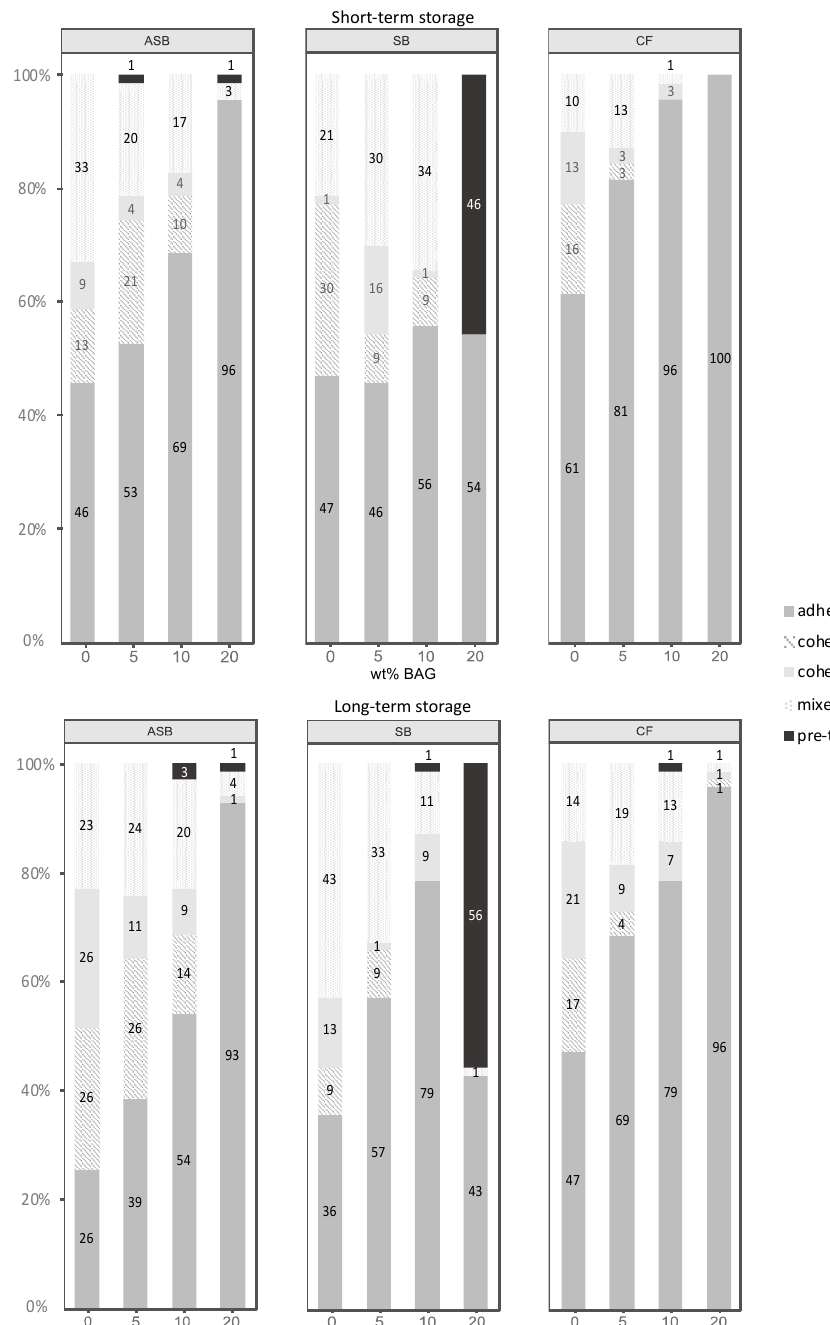
Figure 3. Distribution of failure modes in percentages for the short-term (24 h) and long-term (6 months) storage. ASB: Adper Scotchbond Multi-Purpose; SB: Solobond Plus; CF: Clearfil SE Bond. Both after 24 h and six months of storage, the percentage of adhesively failed sticks increased with higher concentrations of BAG. The percentage of cohesive or mixed fail- ures was highest in the control groups (ASB-0, SB-0, and CF-0) and decreased with the concentration of BAG. An exception to this pattern was observed when SB was modified with 20 wt% of BAG (SB-20), which showed a high incidence of PTFs. In this group, 46% were identified as PTFs after 24 h, whereas after six months, more than half of the sticks